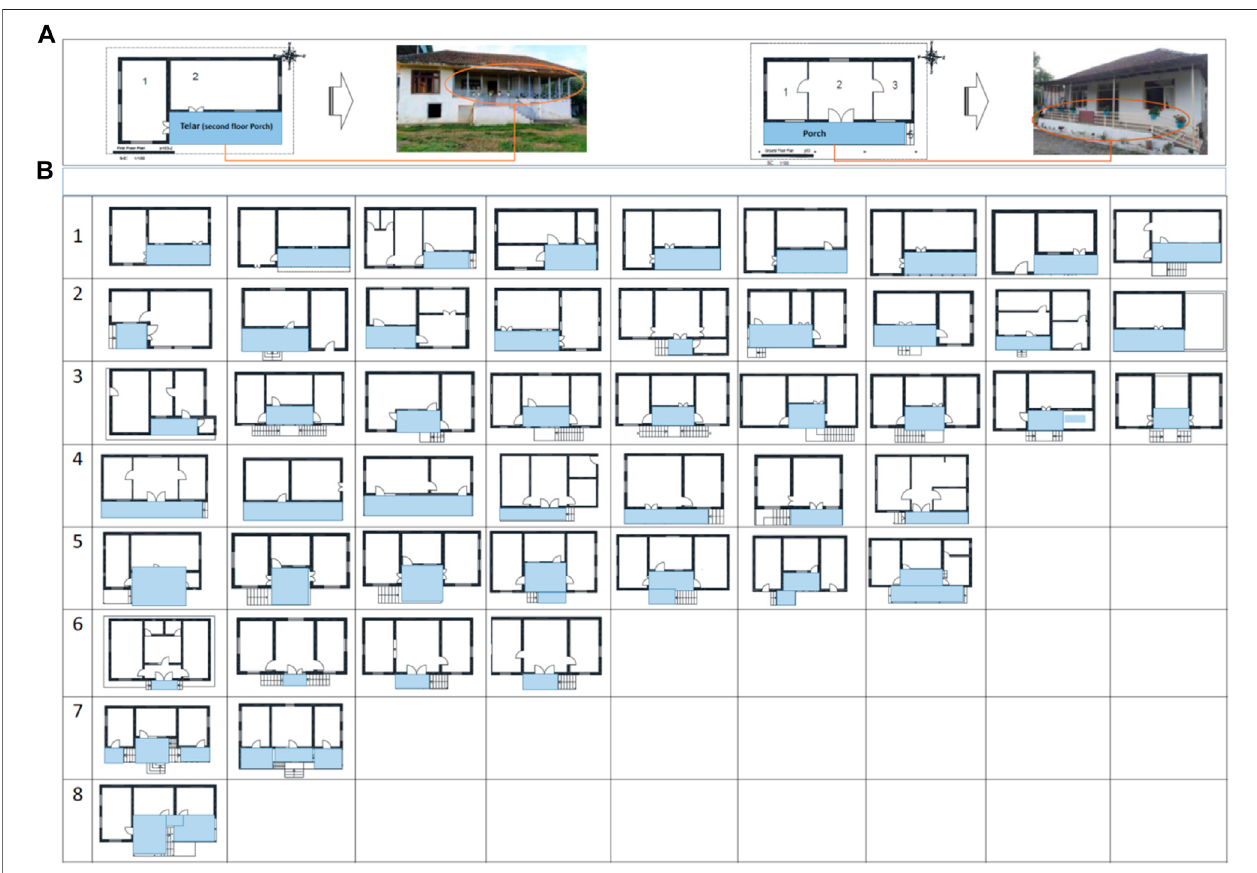
FIGURE 11 | Classi fi cation of houses (A) An example of a single-story house and Tellar house (B) Classi fi cation of form and location of porches, Source: Authors.